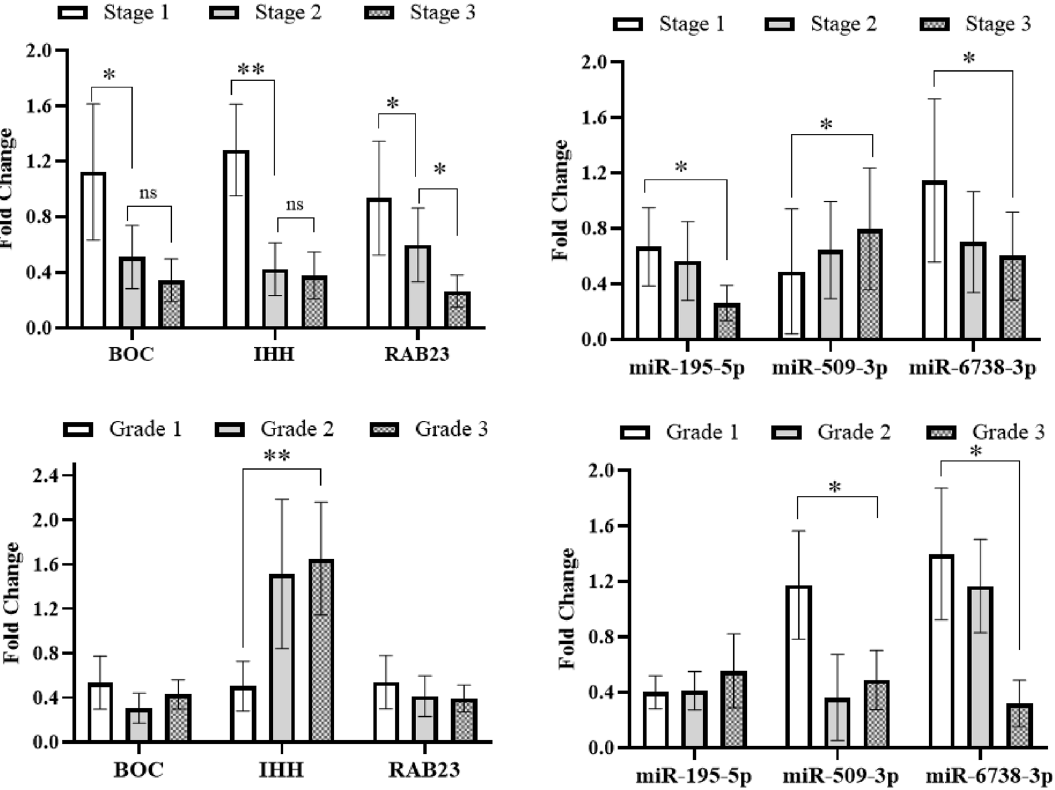
Figure 4. Shh signaling pathway genes and their regulatory miRNAs fold changes in tumor gastric cancer tissues in comparison with their non-tumoral counterparts according to clinicopathological features. * and ** indicates significant difference P < 0.05 and P < 0.01,